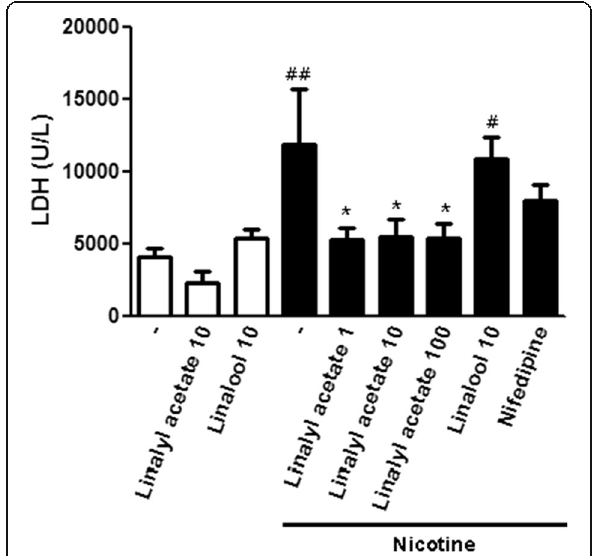
Fig. 2 Effect of linalyl acetate and linalool on lactate dehydrogenase (LDH) activity in nicotine-untreated and treated rats. LDH on serum was measured to evaluate cell damage. Data represent mean values ± S.E.M. ( n = 4 – 6 per group). ## p < 0.01, # p < 0.05 compared with the control group; * p < 0.05 compared with nicotine